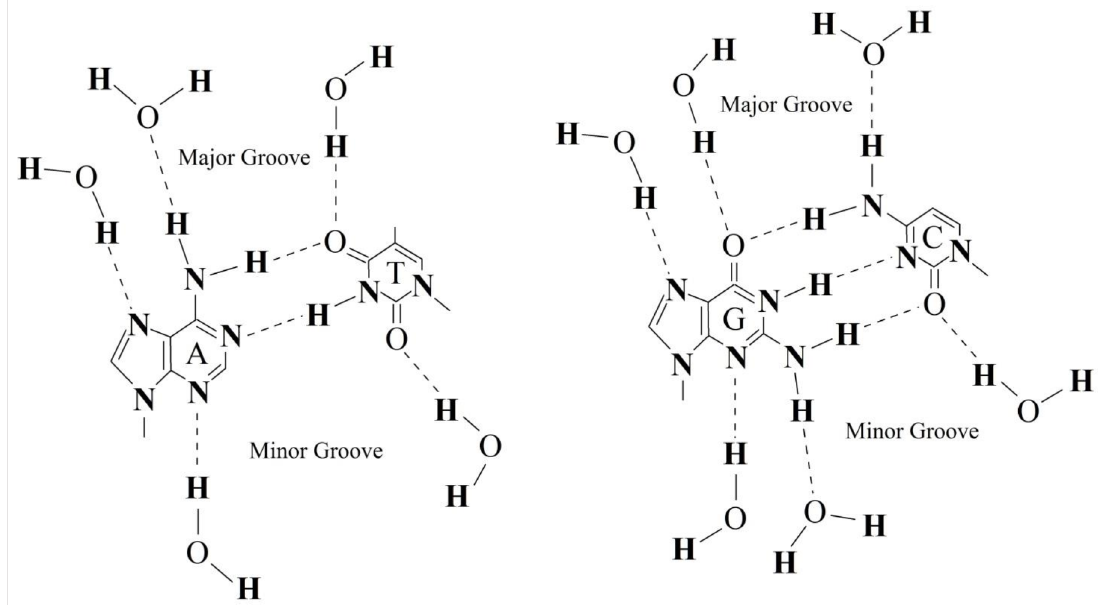
Figure 4. Schematic representation of water molecule hydrogen bonding in the minor and major grooves of DNA double helix. Complementary pairs of nitrogen bases, A-T ( left ) and G-C ( right ) are